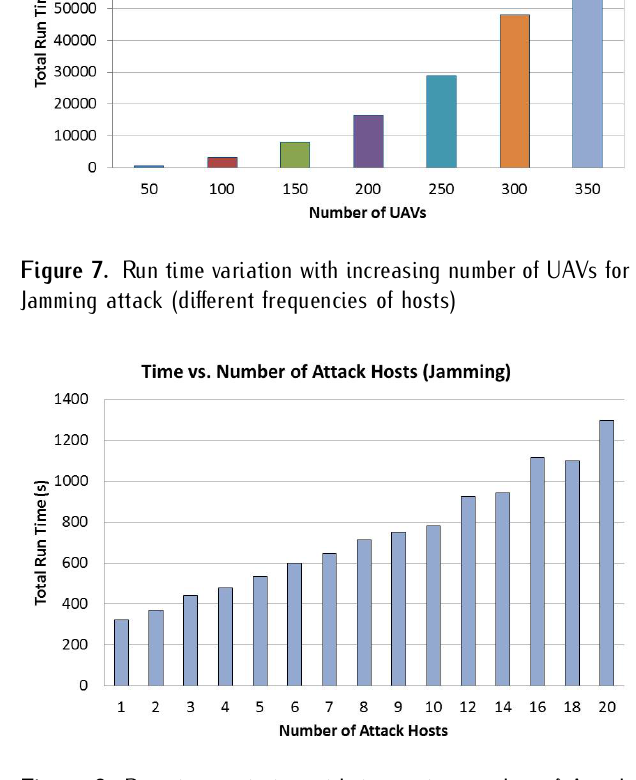
Figure 8. Run time variation with increasing number of Attack Nodes for Jamming attack (different frequencies of hosts as well as attack nodes)